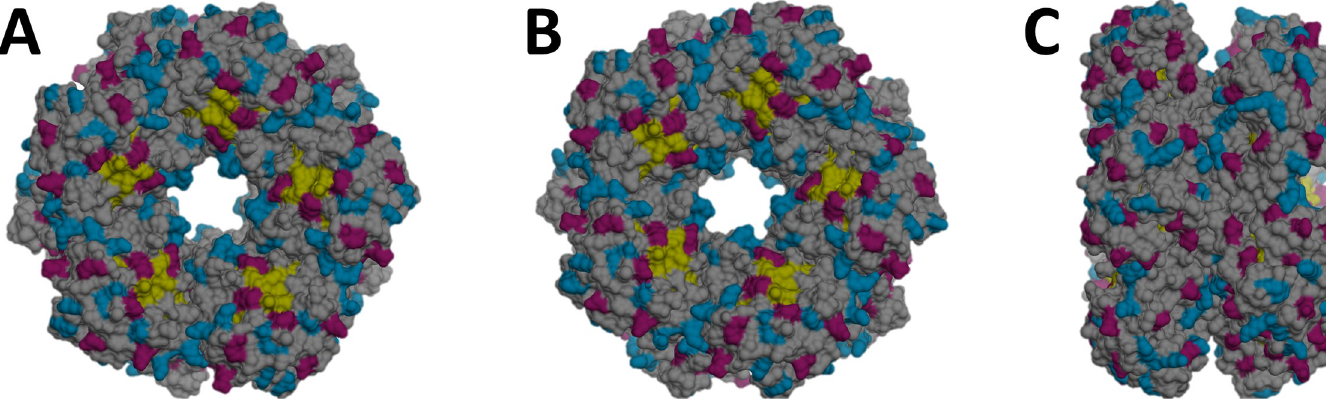
Fig 2. Tridimensional structure of fructose-6-phosphate aldolase (FSA). The entrances to the two active sites are located between the Lys85 from five subunits, in yellow. Acid residues are colored in red; basic residues are in blue. His-tag is not shown; not included in the file used from the Protein Data Bank (PDB) [7]. View: (A) front, (B) back, (C) side. Represented using UCSF Chimera software.